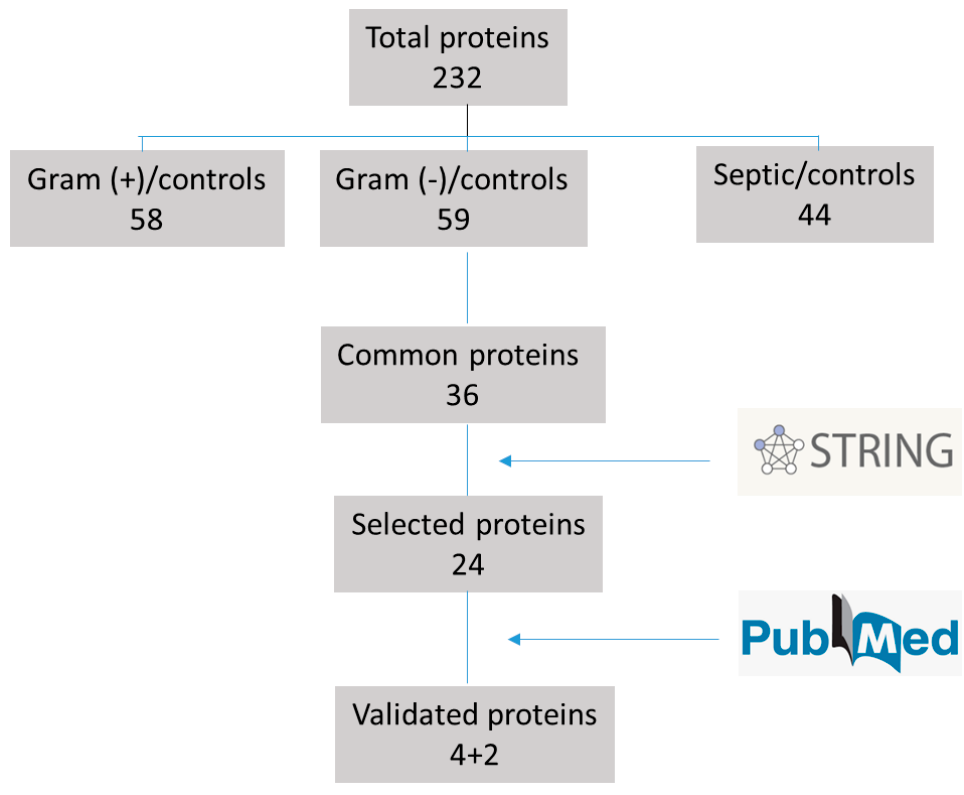
Figure 2. Flow chart performed for deciding validation of proteins.